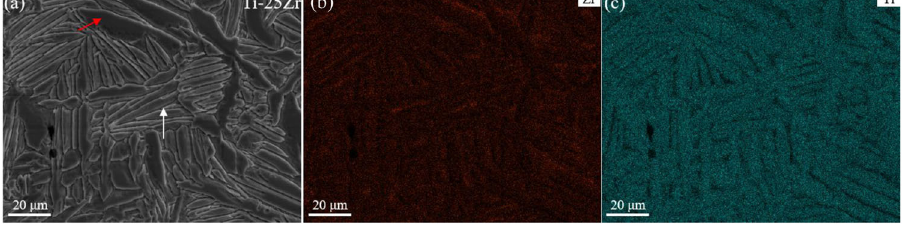
Fig. 4 EPMA element scanning diagram of the Ti-45Zr alloy: ( a ) Ti-45Zr; ( b ) Ti and ( c ) Zr